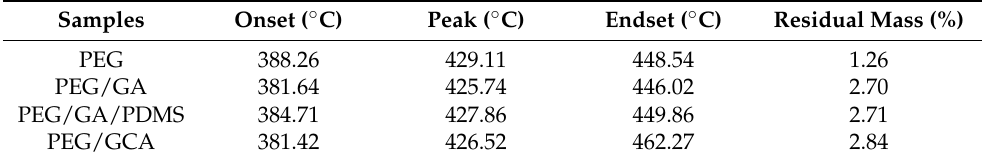
Table 3. TGA characteristics of the pure PEG and PEG composites under N 2